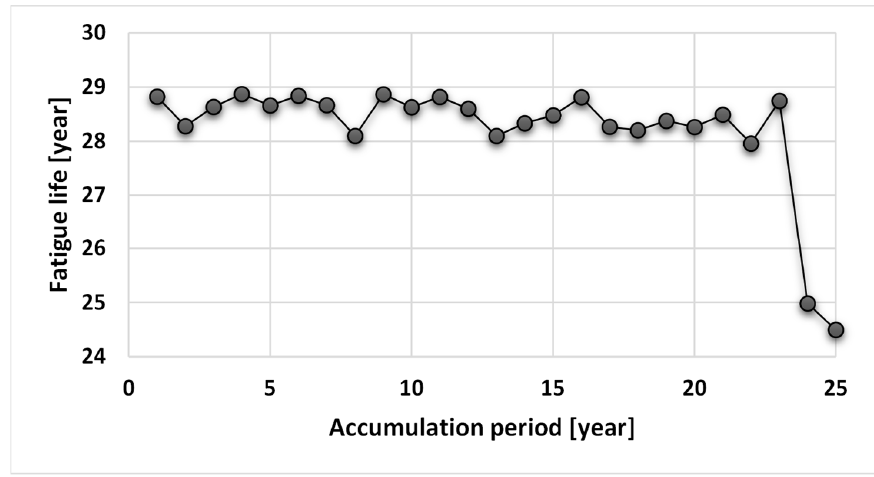
Figure 10. Fatigue life according to the accumulation period of wind.